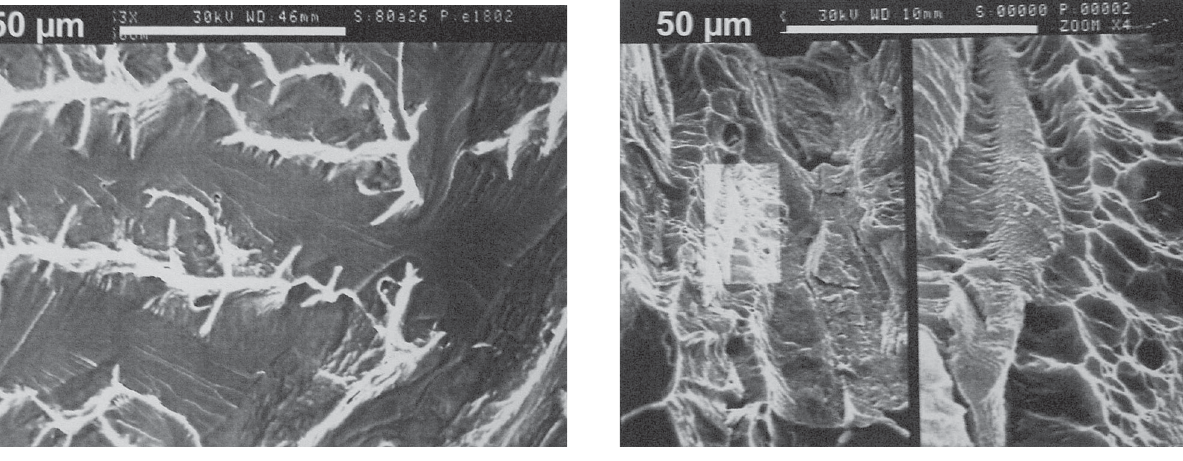
Figure 4. Fracture surface of aged material a) F32 Shows cleavage of the ferrite and necking of austenite b) F20 showing fragile shearing in ferrite and tearing of austenite.